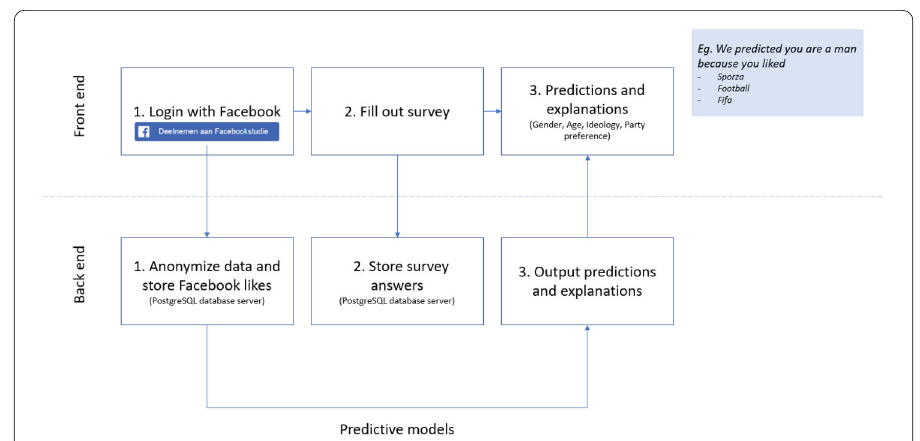
Figure 4 Overview of the front- and back end of the webpage that was created to collect Facebook like data for our